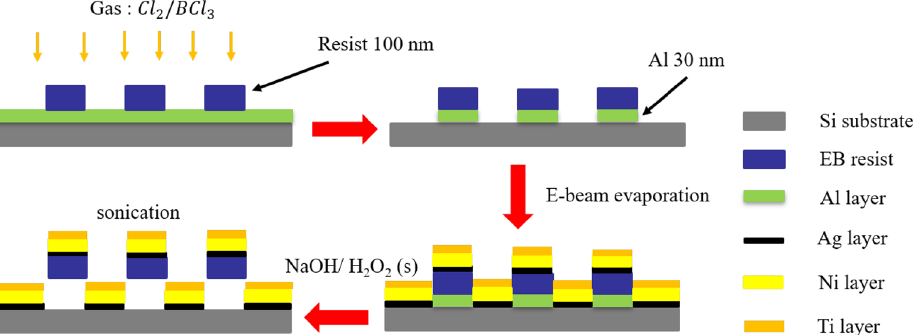
Figure 1. The preparation process of L-shaped nanorobots: ( a ) deposited Al layer through EBE, create resist patterns through EBL, and etch Al layer through ICP etching; ( b ) removed Al from regions not shielded by EB resist patterns; ( c ) deposited Ag, Ni, and Ti through EBE; ( d ) dissolved Al layer using NaOH and H 2 O 2 solution to release the